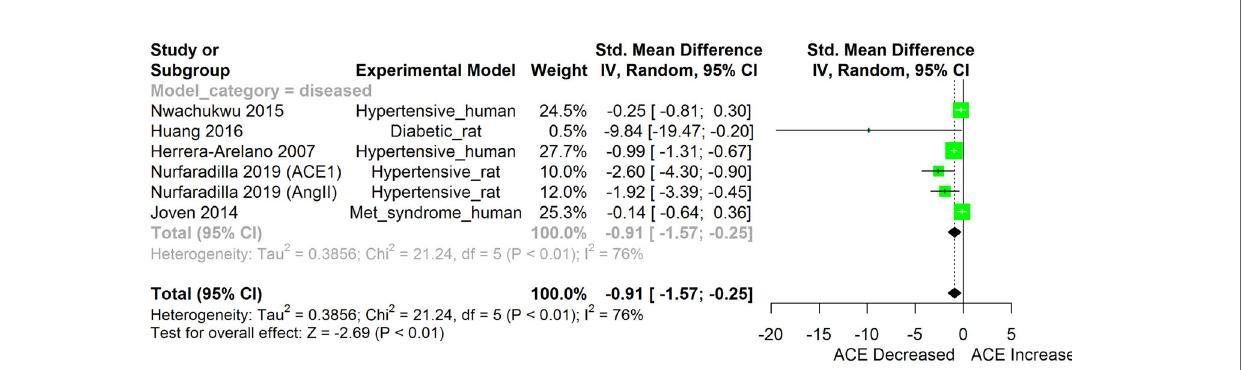
FIGURE 3 | Meta-analysis and forest plot of the effect of HS administration on Angiotensin converting enzyme cascade. The meta-analysis was sub-grouped by health status (i.e diseased or healthy state). The standardized mean difference (SMD), which is an estimate of the effect size, is presented as a square on the forest plot, for each study and as a diamond for the pooled estimate of each subgroup or overall studies. The overall pooled SMD for all included studies is shown in the bottom section of the forest plot. SMD data points that are lower than zero signify that treatments with HS lower the level of the biomarker while those greater than zero signify that HS treatment causes an increase in the levels of the biomarker. The statistical signi fi cance of the pooled estimate is indicated by the Z test of signi fi cance. Met,